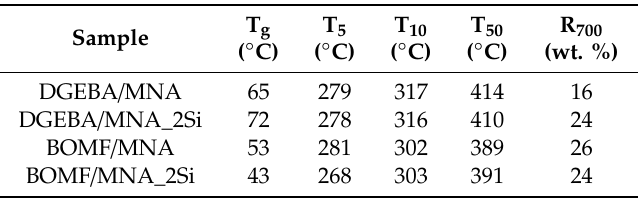
Figure4. ( a )TGAand( b )derivativecurves(DTG)thermogramsofepoxyresinsandepoxy / silicahybrids. Table 3. Values of glass transition temperature ( T g ) measured using di ff erential scanning calorimetry (DSC), temperatures at which 5% ( T 5 ), 10% ( T 10 ) and 50% ( T 50 ) weight loss are recorded and residues weight at 700 ◦ C (R 700 ), collected using TGA